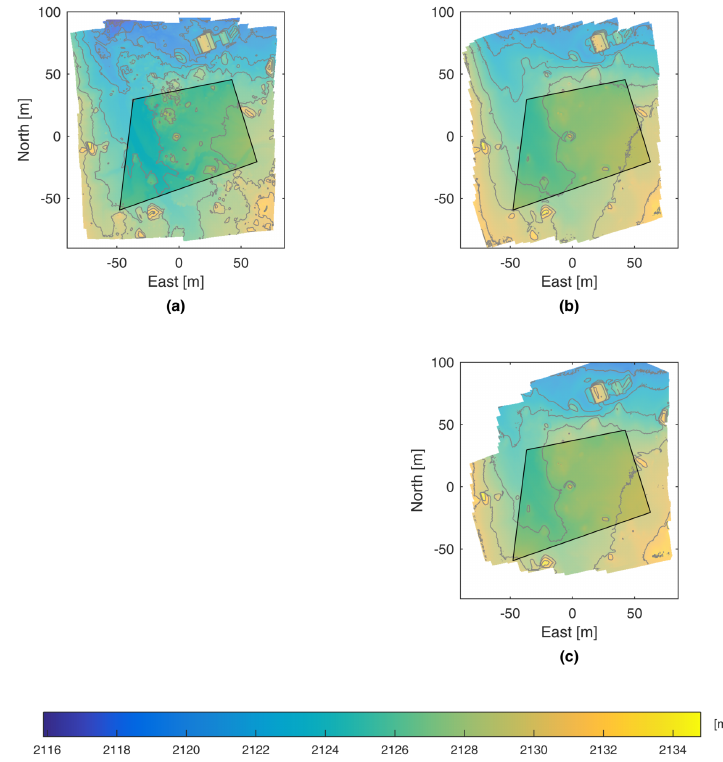
Figure 2. Digital Surface Models from the UAS surveys during summer 2016 (( a ), top-left), winter 2016 (( b ), top-right) and winter 2017 (( c ), bottom-right). The color map represents surface height (ASL). Contour lines (grey) are reported with an equidistant interval of 2 m. No bare-soil survey was performed during summer